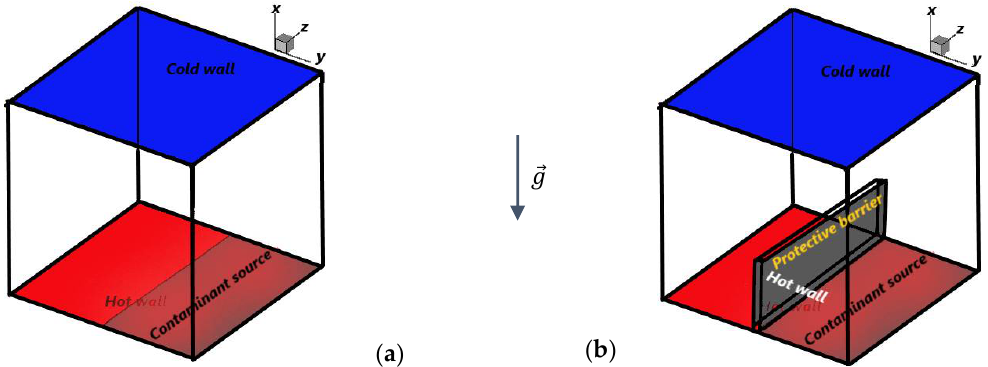
Figure 1. Physical model of the building: ( a ) Reference model without barrier; ( b ) Building with barrier.